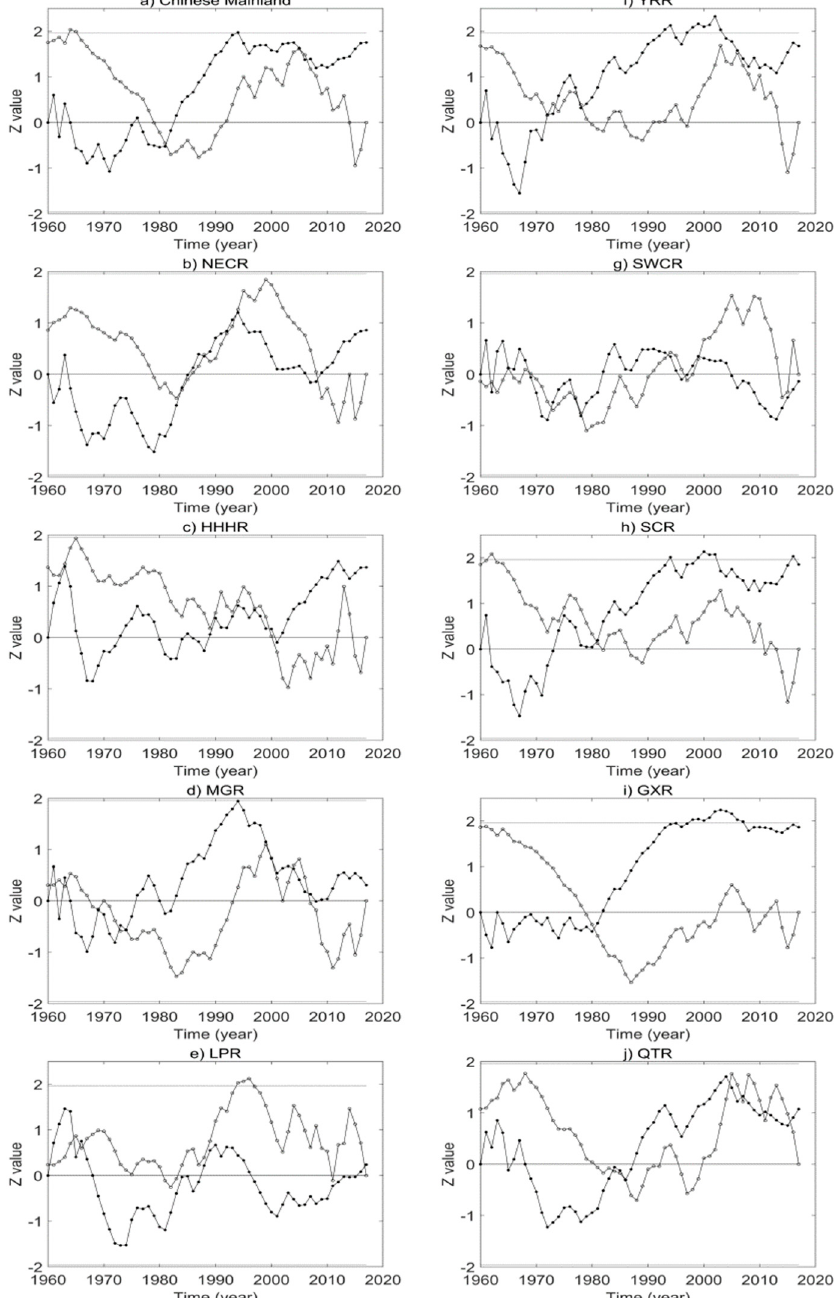
Figure 4. Abrupt changes analysis for annual SPEI_pm of Chinese Mainland. ( a ) represents the Chinese mainland, and ( b – j ) represent the NECR, HHHR, MGR, LPR, YRR, SWCR, SCR, GXR, and QTR, respectively. The solid points are on the UF curve and the hollow points are on the UB curve. UF and UB represent the statistics of forward and backward sequence, respectively.